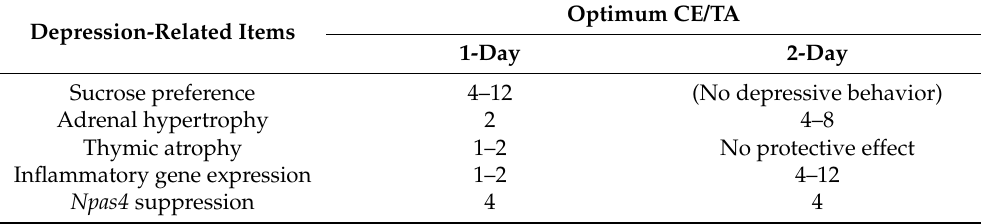
Table 4. Preventive effects of tea consumption on depression-related factors in LPS-treated